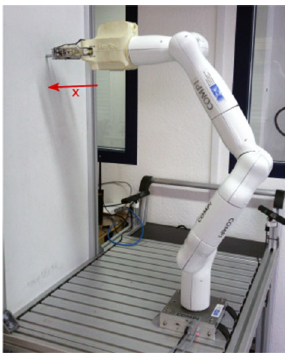
Fig. 11 Experimental setup used in the static contact force experi- ment using COMPI manipulator